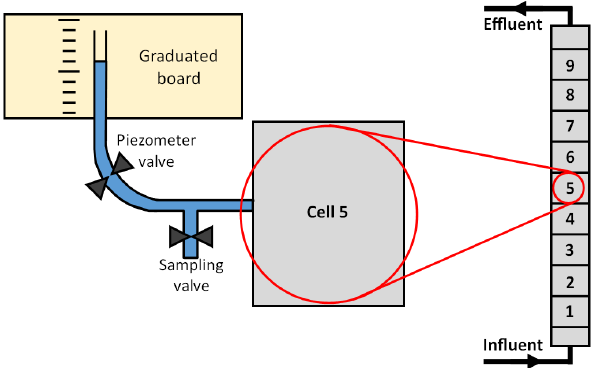
Figure 1. Schematic of column 1, with cell numbers labelled on the column. Details of valves and piezometer are shown for cell 5.